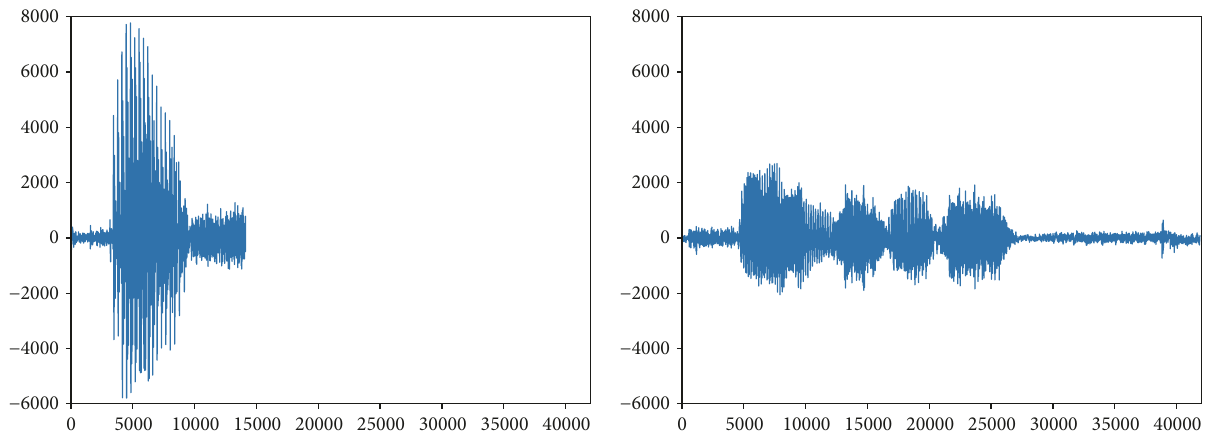
Figure7:Oscillogramfortwodifferentrealizationsoftheword crisis withdifferentdegreesofreductionintheNewsScapearchive:[kraız](left) and [k h raısıs](right).